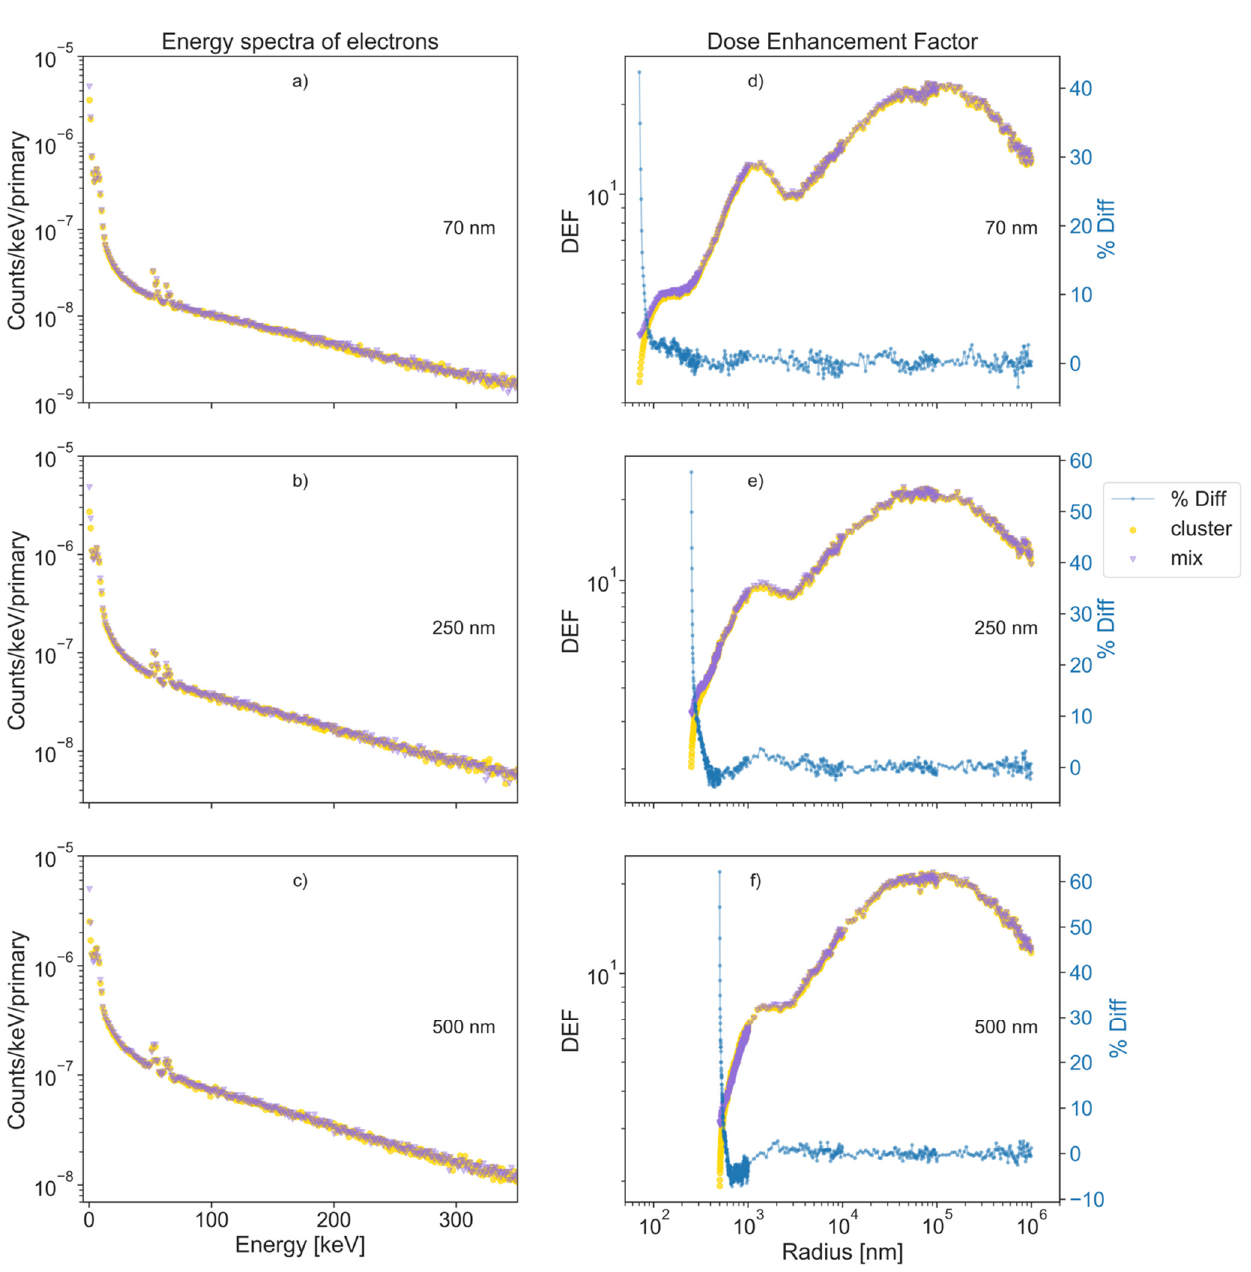
Figure 2. Three different cluster sizes of 70, 250, and 500 nm, ( a – f ) each made of 333 GNPs of 7, 25, and 50 nm radii, respectively (top to bottom), were irradiated with a 6 MV energy spectrum from a TrueBeam Varian Linac. Left columns ( a, b and c ) show the energy spectra of electrons created inside the cluster and a MixNP that escaped from it (yellow and purple, respectively), for all cluster sizes. Here, the highest difference between both spectra is at the first energy bin, which corresponds to energies below 0.1 keV. In the right column, ( d – f ) show the DEF of the MixNP and the full cluster, and also the %Diff (in blue) for a better visualization of the differences on the DEF for all sizes. Here, we observed that a higher number of low-energy electrons from the MixNP leads to an enhancement of the DEF at small radii, compared to the DEF of the cluster. The high values of the %Diff at small radii are associated to the models used to simulate full clusters, where the gold concentration decreases at the surface of the cluster. It is shown in the Supplementary Material that the values of the %Diff were reduced dramatically when a more complex MixNP was modelled as two concentric spheres made of water and a mix of gold plus water for the outer and the inner sphere, respectively.